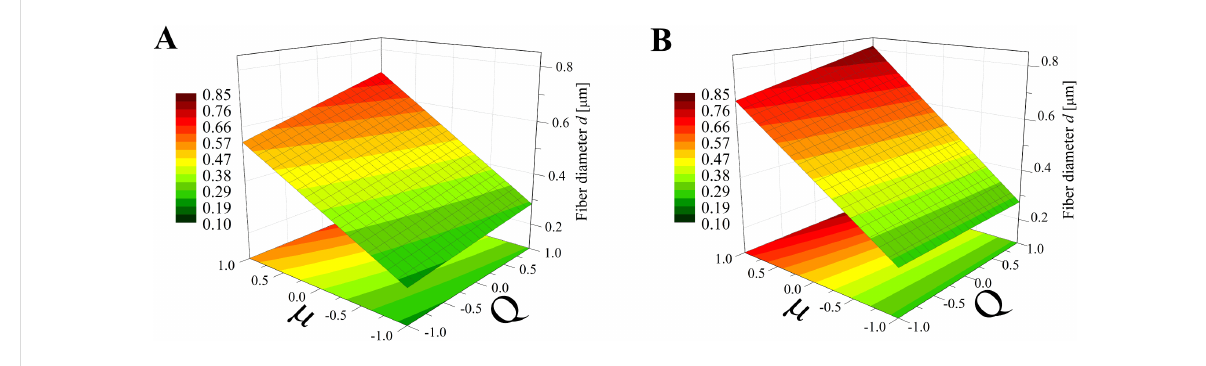
Figure 10: Response surface plots presenting the dependence of the diameter of the obtained beaded fibers ( d ) on the dynamic viscosity (µ) and the flow rate ( Q ) of the polymer solution for (A) maximum electrical voltage ( U = +1) and (B) minimum electrical voltage ( U = − 1) .